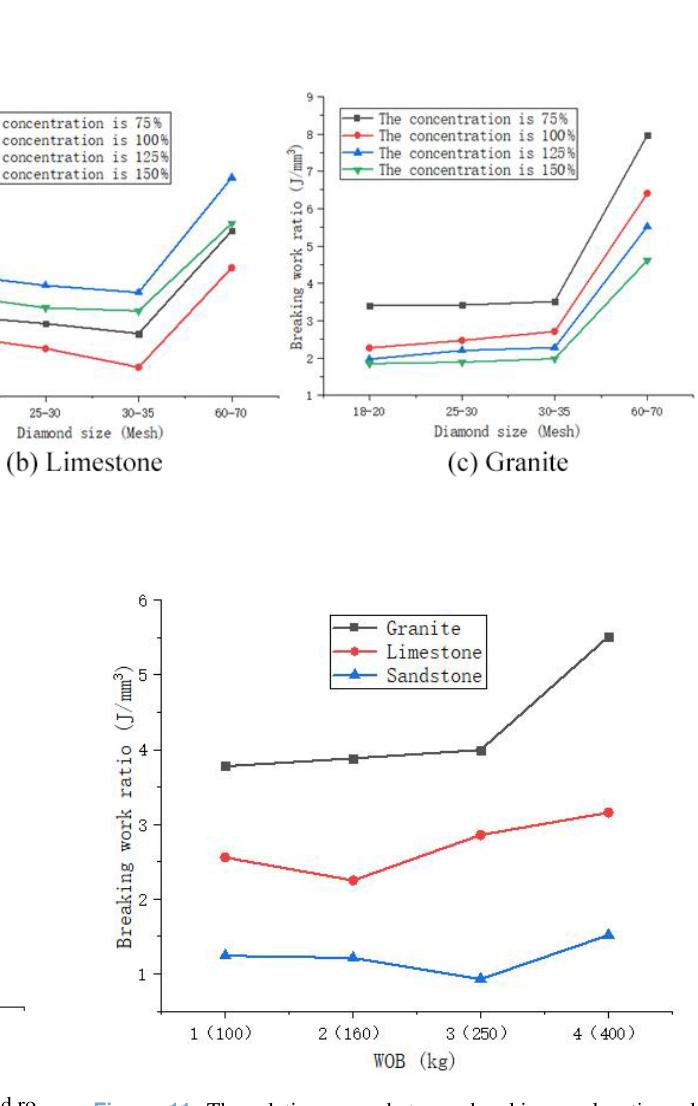
Figure 11. The relation curve between breaking work ratio and